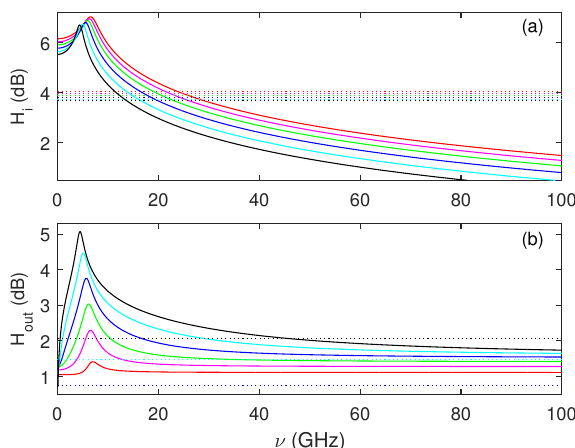
Figure 4. (color online) Small-signal modulation response of EAM-VCSEL for the case of strong coupling ( d EAM = 0.4972 µ m) and when modulating ( a ) injection current, i.e., H i ( ν ) from Equation (21) and ( b ) EAM losses α EAM , i.e., H out ( ν ) from Equation (18). Different colors correspond to different bias points for the EAM losses α EAM : 8500cm − 1 (red), 6700cm − 1 (magenta), 5100cm − 1 (green), 3500cm − 1 (blue), 1900cm − 1 (cyan), 500cm − 1 (black). The dotted straight lines denote the 3 dB limit for the modulation curves with the same color.